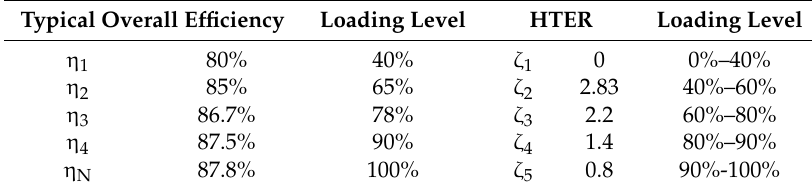
Table A1. Efficiency and HTER of CHP.